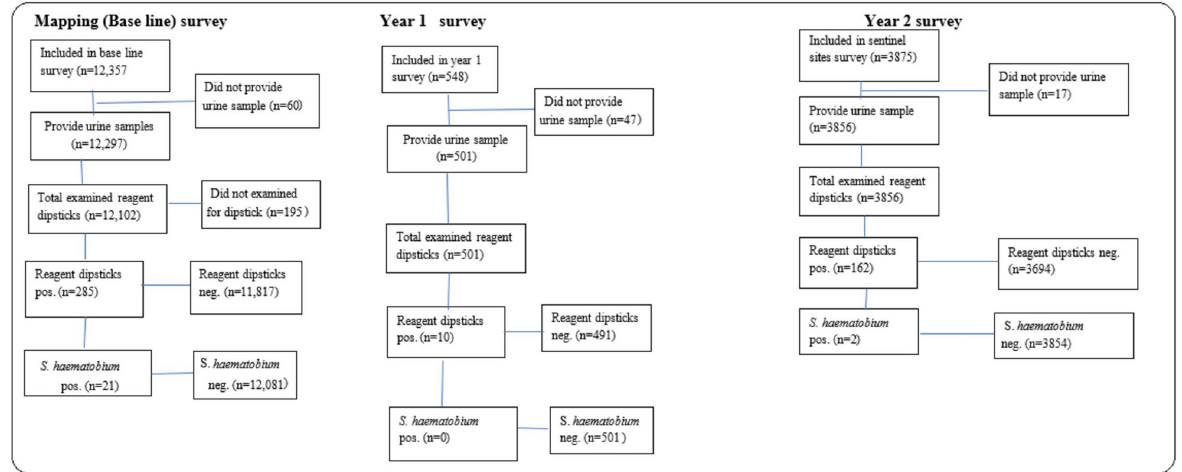
Fig 1. Flowchart of study phase participation, sample provision and diagnostic tests performed during the study period.